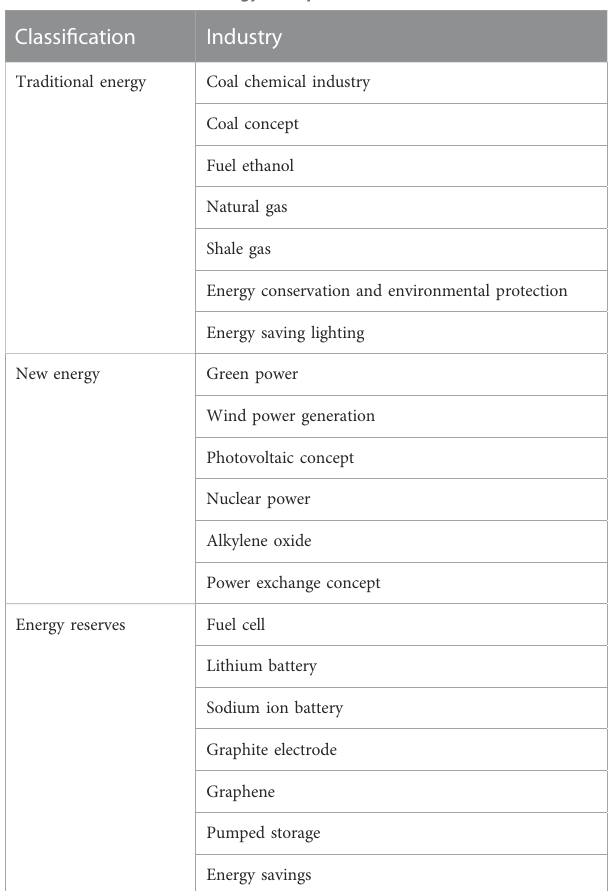
TABLE 4 Classi fi cation of energy